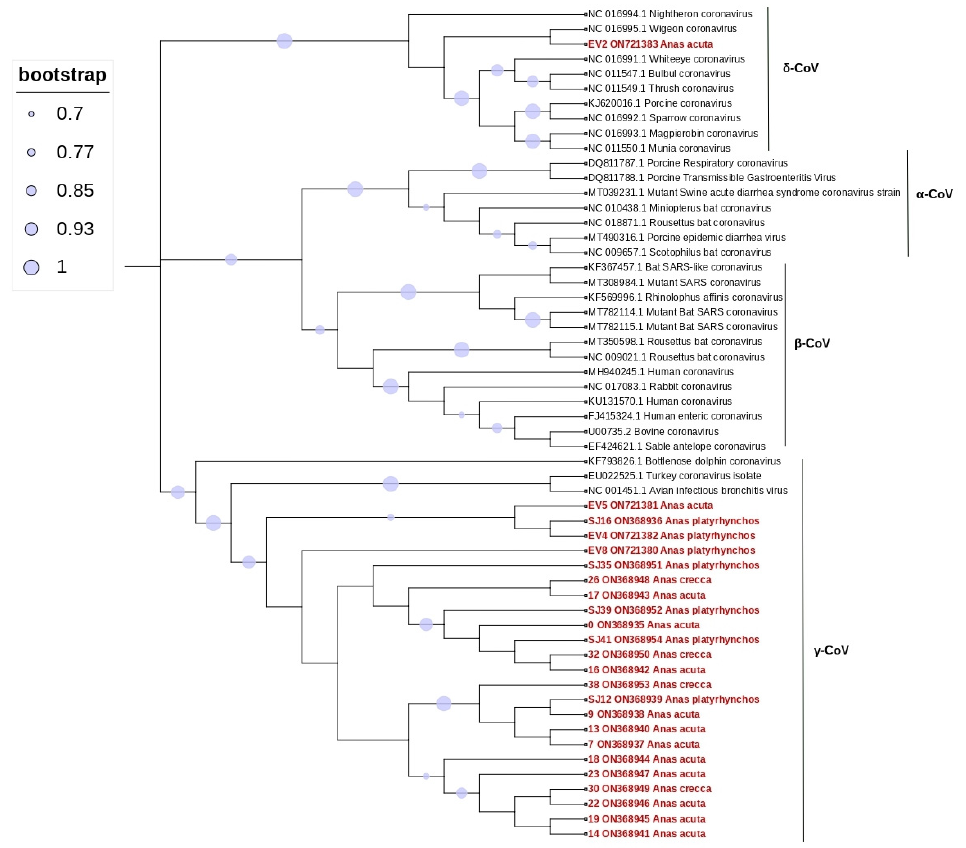
Figure 2. Phylogenetic tree constructed for the alpha , beta , gamma , and delta coronavirus, using 36 reference strains and 24 strains identified in this study. Phylogenetic analysis was based on a 406 nt partial region of the RdRp. The tree was constructed using MEGA 10 using the maximum likelihood based on the GTR + G model, and 1000 bootstraps were replicated. Samples from this study are indicated in red.